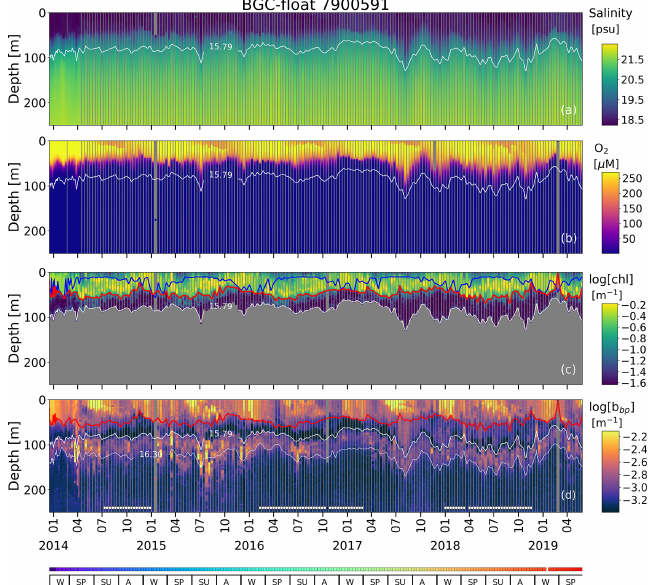
Figure A2. Time series of (a) S, (b) O 2 , (c) log ( chl ) , and (d) log (b bp ) for float 7900591. The blue line in (c) indicates the mixed layer depth. The red lines in (c) and (d) show the base of the productive region. Isopycnals 15.79 and 16.30kgm − 3 describe the top and bottom of the oxygen-poor zone (OP DA ), respectively. SU, A, W, and SP stand for summer, autumn, winter, and spring, respectively. The colored horizontal line at the bottom indicates the sampling site for a given date (Fig. A1). The horizontal white lines in (d) are the profiles used to (1) delimit the OP DA and (2) find the isopycnals at which b bp is maximum in the OP DA . chl is set to zero in the OP DA due to fluorescence contamination (Stanev et al.,